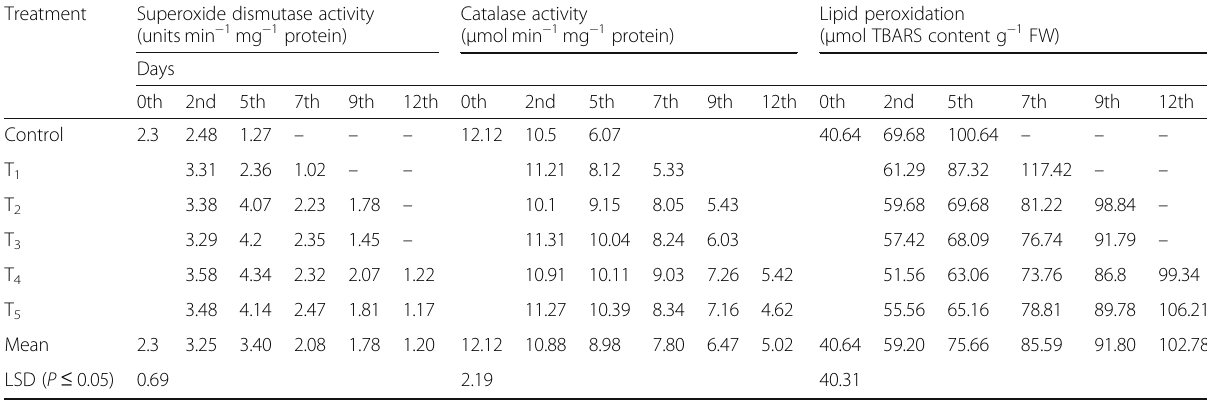
Table 2 The effect of different vase solutions on the activity of superoxide dismutase, catalase, and lipid peroxidation in gladiolus cut spikes at different stages of vase life